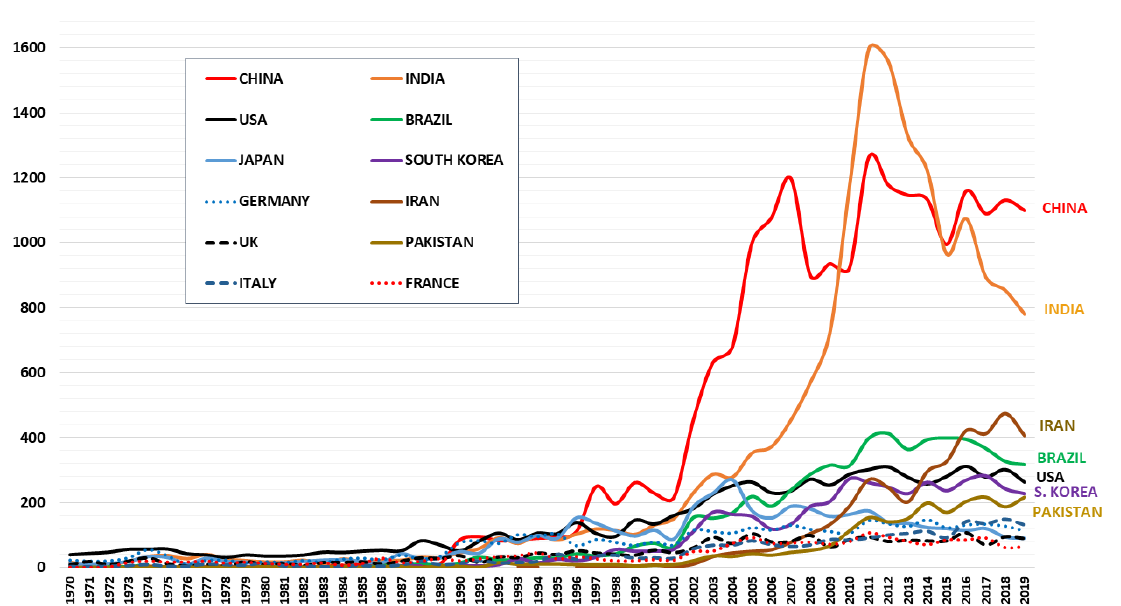
Figure 5. Temporal evolution on medical plants publications for Top 12 countries.